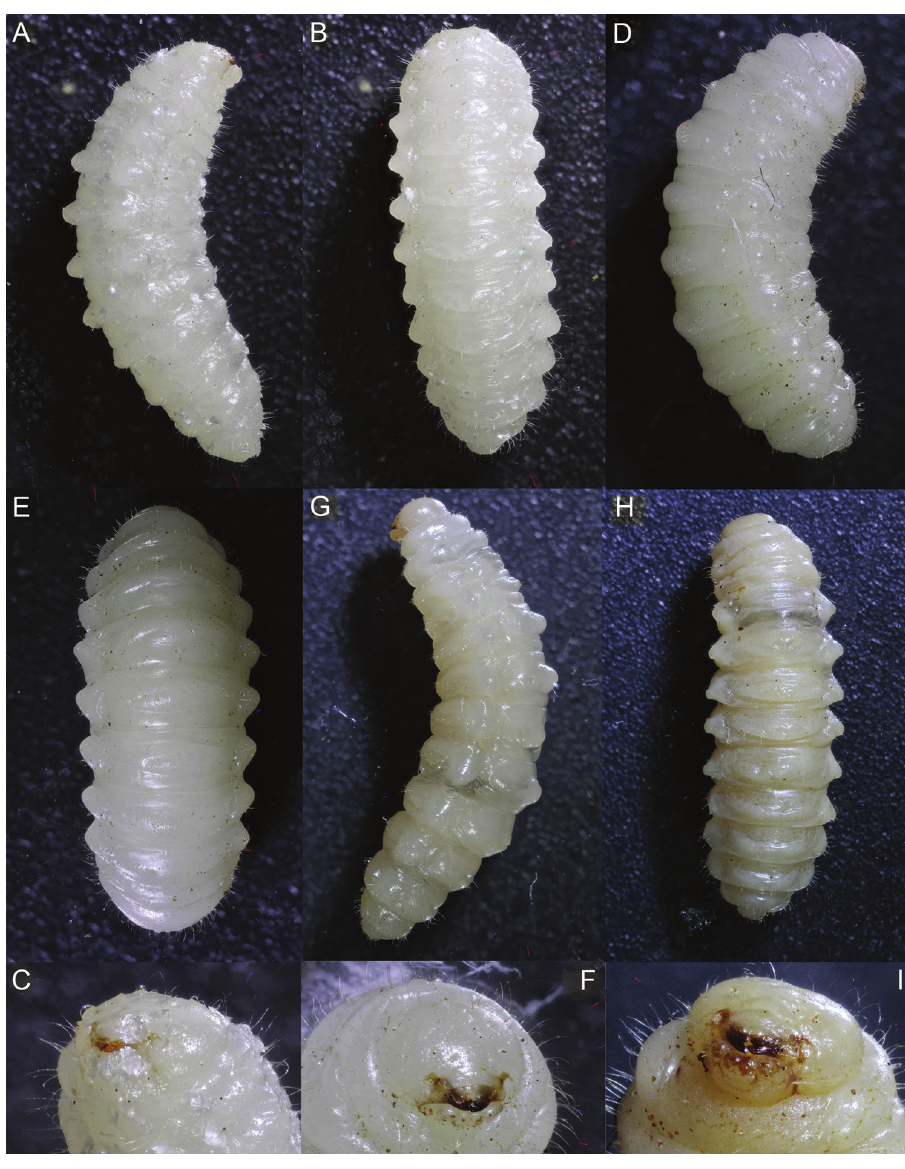
Figure 4. Larvae of Gasteruption . Gasteruption assectator . A mature larva, lateral view B mature larva, dorsal view C head – mouthparts. Gasteruption nigrescens D mature larva, lateral view E mature larva, dorsal view F head – mouthparts. Gasteruption phragmiticola G mature larva, lateral view H mature larva, dorsal view I head –